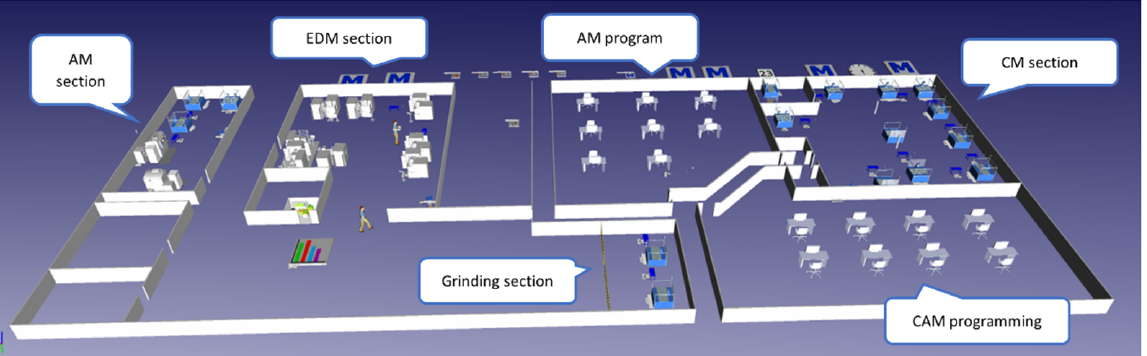
Figure 4. Three ‐ dimensional model setup used for the manufacturing flow simulation (from Tecn ‐ Figure 4. Three-dimensional model setup used for the manufacturing flow simulation (from Tecno- omatix Plant Simulation). matix Plant